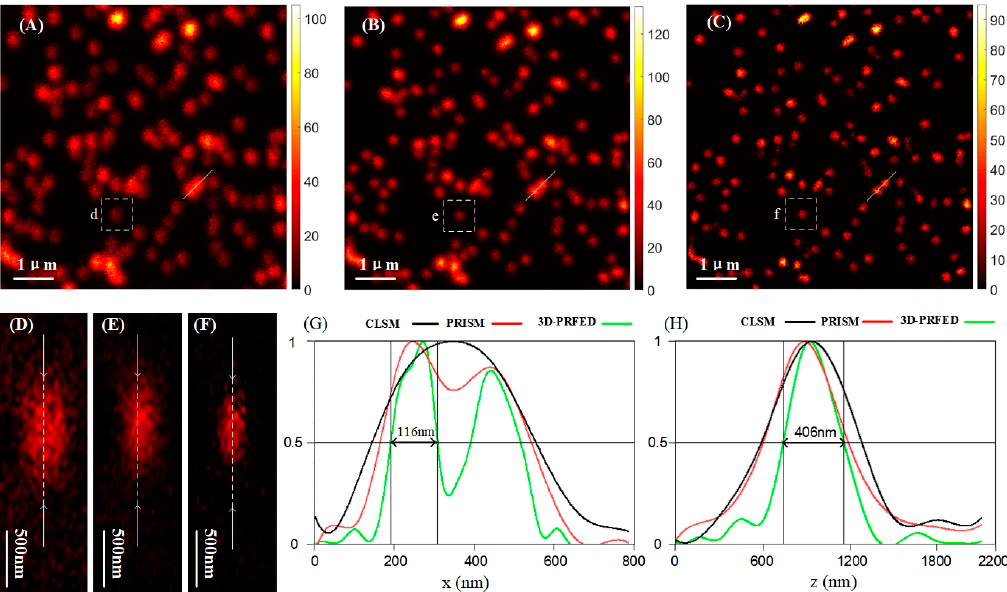
Figure 6. The comparison among 100 nm nanoparticle test results in CLSM, PRISM, and 3D-PRFED ( γ = 0.7). ( A ) CLSM image at the focal plane. ( B ) PRISM image at the focal plane, ( C ) 3D-PRFED image at the focal plane. ( D – F ) are the cross-section view of a single nanoparticle in the dashed box region of ( A – C ), respectively. ( G ) The transverse normalized profile along the white line in ( A – C ). ( H ) The axial normalized profile along the dashed line in ( D – F ). Scanning parameter: 6 μ s/pixel, 30 nm transverse pixel size, 50 nm axial pixel size.